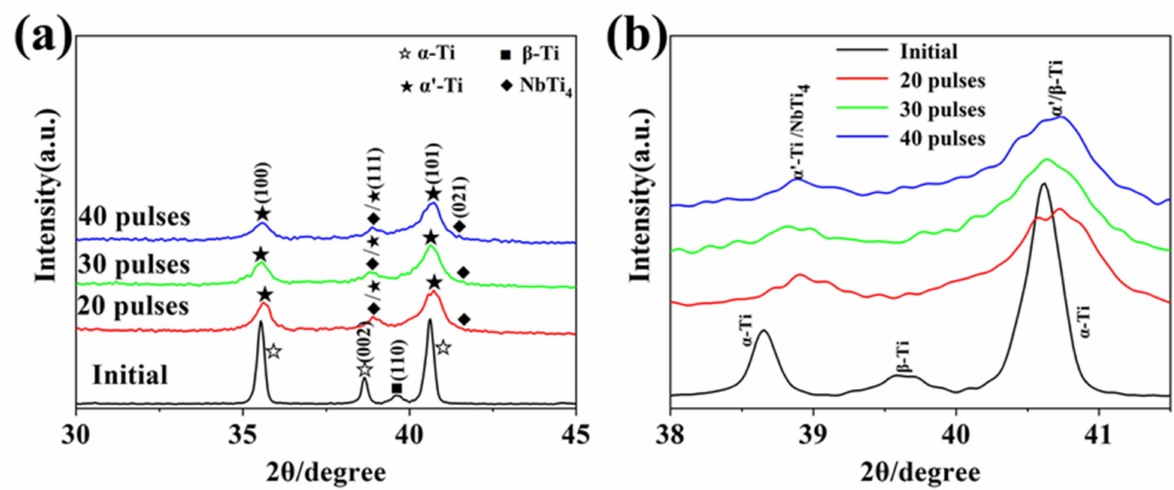
Figure 1. XRD analysis results of the samples before and after Nb alloying. ( a ) XRD patterns; ( b ) Magnified picture of the diffraction peaks near 40 ◦